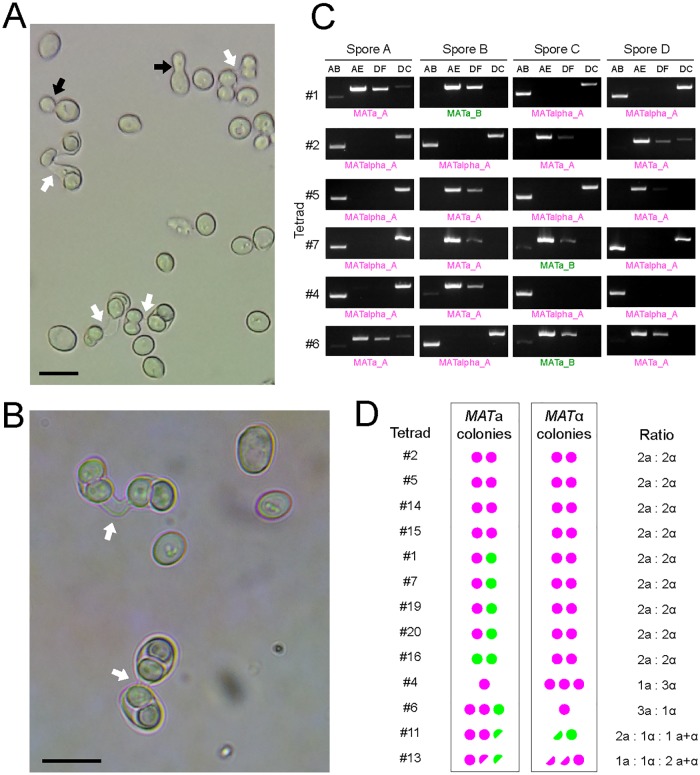
(A,B) Ascospore formation in Z. parabailii ATCC60483. White arrows show conjugation tubes in dumbbell-shaped asci. Black arrows show budding vegetative cells. Scale bars, 10 μm. Cultures were grown on 5% malt extract agar for 6–10 days at 25°C. (C) Examples of PCR determination of MAT locus genotypes in tetrads. Pairs of PCR primers as shown in Fig 5A were used to amplify the MAT locus in colonies grown from spores after dissection of conjugated asci. PCR primer pairs AB and AE amplify the left side of the MAT locus, including the Z region (AB, 1,485-bp product from MATα; AE, 2,103-bp product from MATa). Primer pairs DF and DC amplify the right side of the MAT locus, including the X region (DF, 1,882-bp product from MATa; DC, 2,027-bp product from MATα). PCR products were sequenced to determine whether they originated from the A- or B-subgenome. (D) Summary of MAT genotypes in colonies grown from spores from 13 dissected tetrads. Magenta circles denote colonies with A-subgenome alleles (MATa_A or MATα_A), and green circles denote colonies with B-subgenome alleles (MATa_B or MATα_B). Half circles represent colonies that gave both MATa and MATα PCR products.